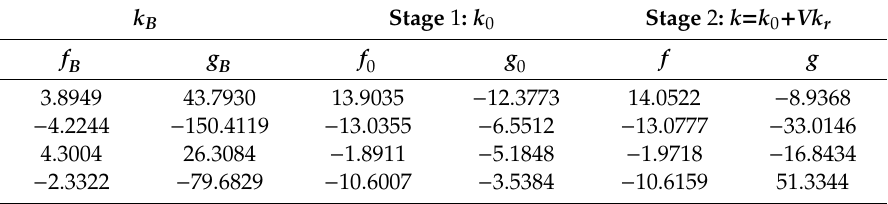
Table 5. Gains comparison: traditional technique, k B , and the proposed method, k (test-case 2).